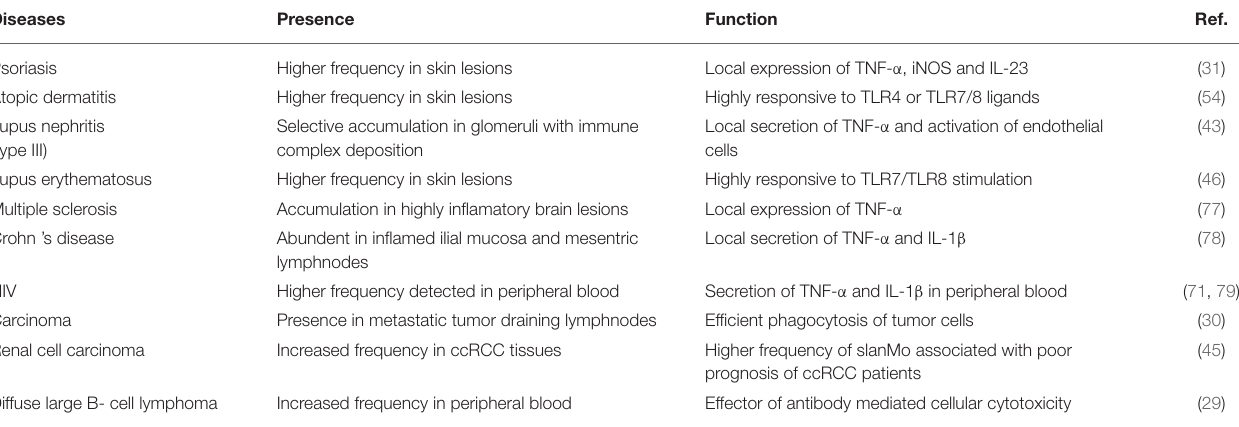
TABLE 2 | The observed location and potential role of slanMo in different